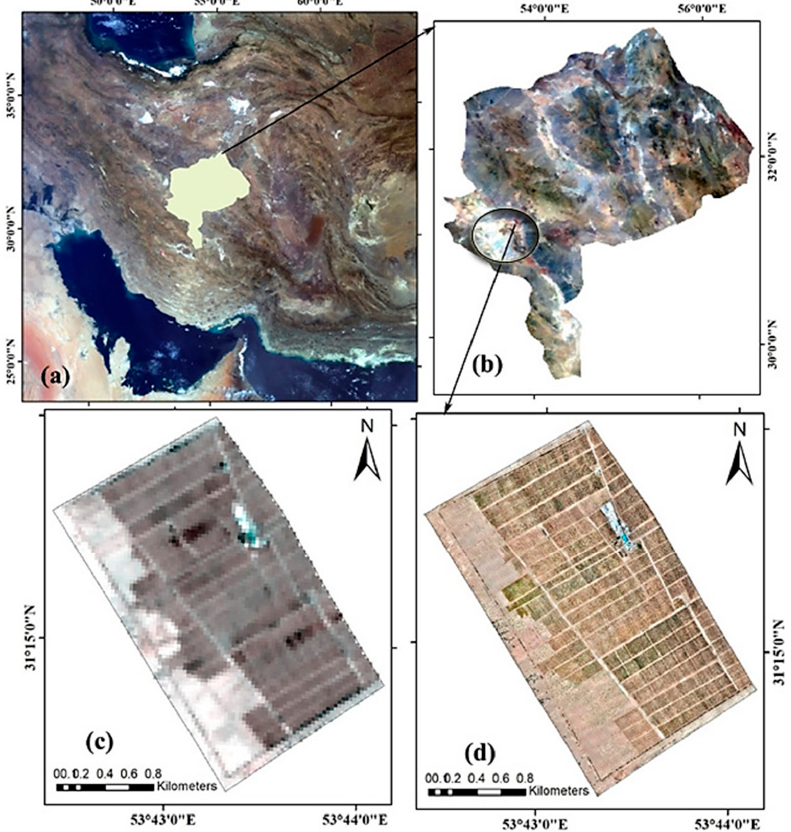
Figure 1. Location of the study area in ( a ) Iran and ( b ) Abarkooh desert and Yazd province, and images from ( c ) Landsat 8 and ( d ) unmanned aerial vehicles